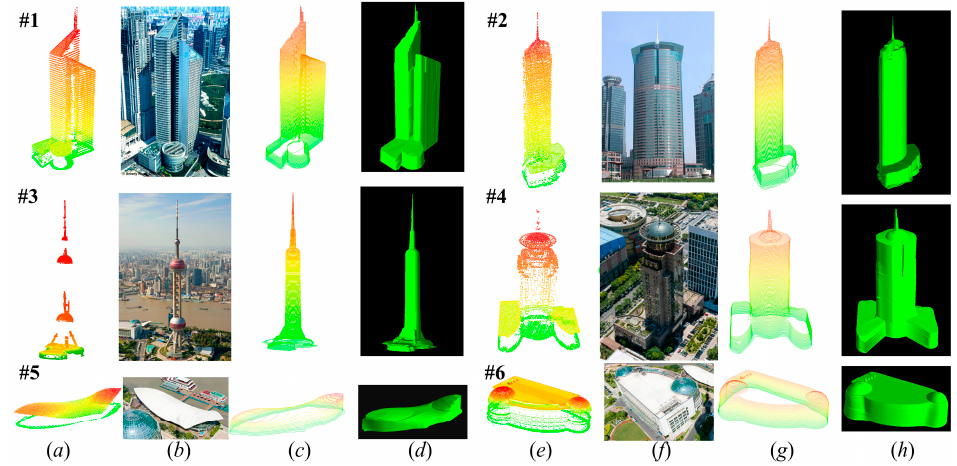
Figure 7. Results on selected buildings: ( a ) and ( e ) are the building point clouds; ( b ) and ( f ) are the outdoor scene pictures; ( c ) and ( g ) are the contours in 3D scene; and ( d ) and ( h ) are the reconstructed building models.